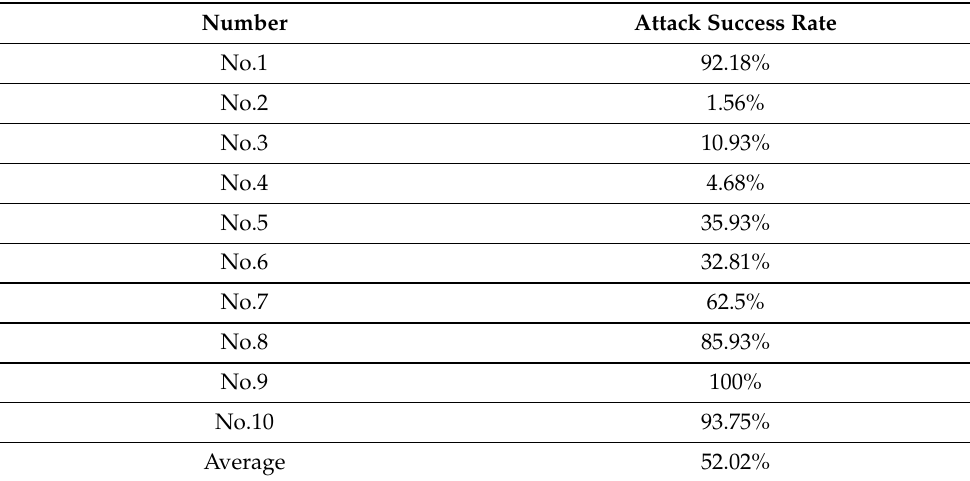
Table 5. Digital dodging attacks against LFW